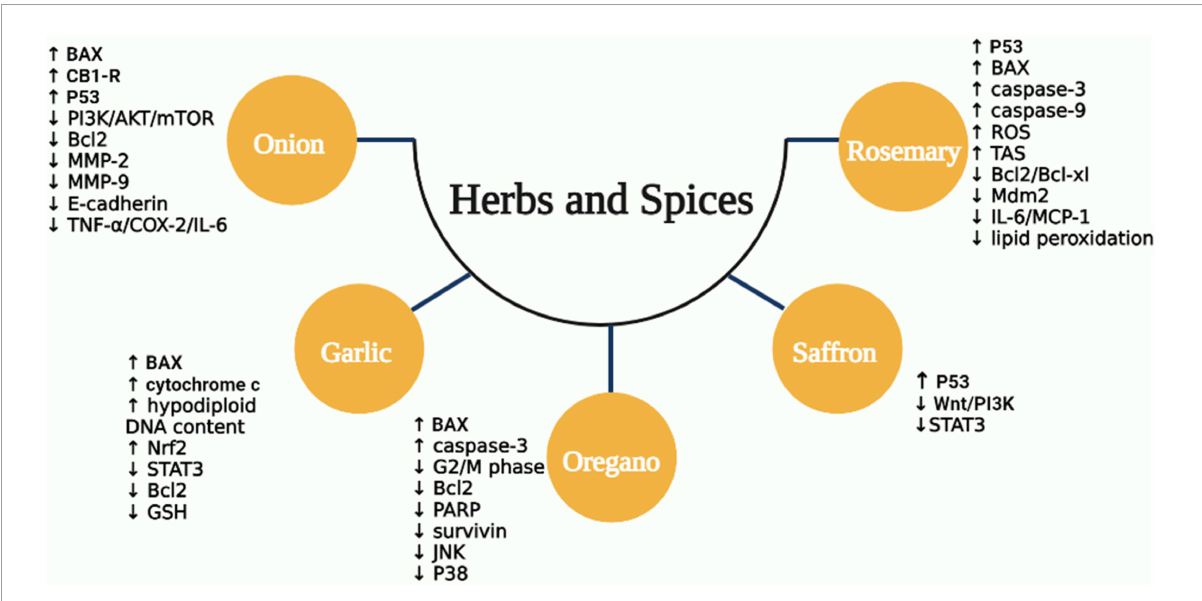
FIGURE4 The mechanisms of anticancer activity for some types of MD herbs and spices. ROS, reactive oxygen species; TNF- α , tumor necrosis factor-alpha; IL, interleukin; COX-2, cyclo-oxygenase-2; MMP-9, matrix metalloproteinases-9; JNK, Jun N-terminal kinase; BAX, Bcl-2-associated X protein; PARP, poly adenosine diphosphate ribose polymerase; Nrf2, nuclear factor-erythroid factor 2; STAT3, signal transducer and activator of transcription 3; GSH, glutathione; CB1-R, cannabinoid receptor type 1; Mdm2, mouse double minute 2 homolog; MCP-1, monocyte chemoattractant protein-1; Wnt, wingless-related integration; PI3K, phosphoinositide